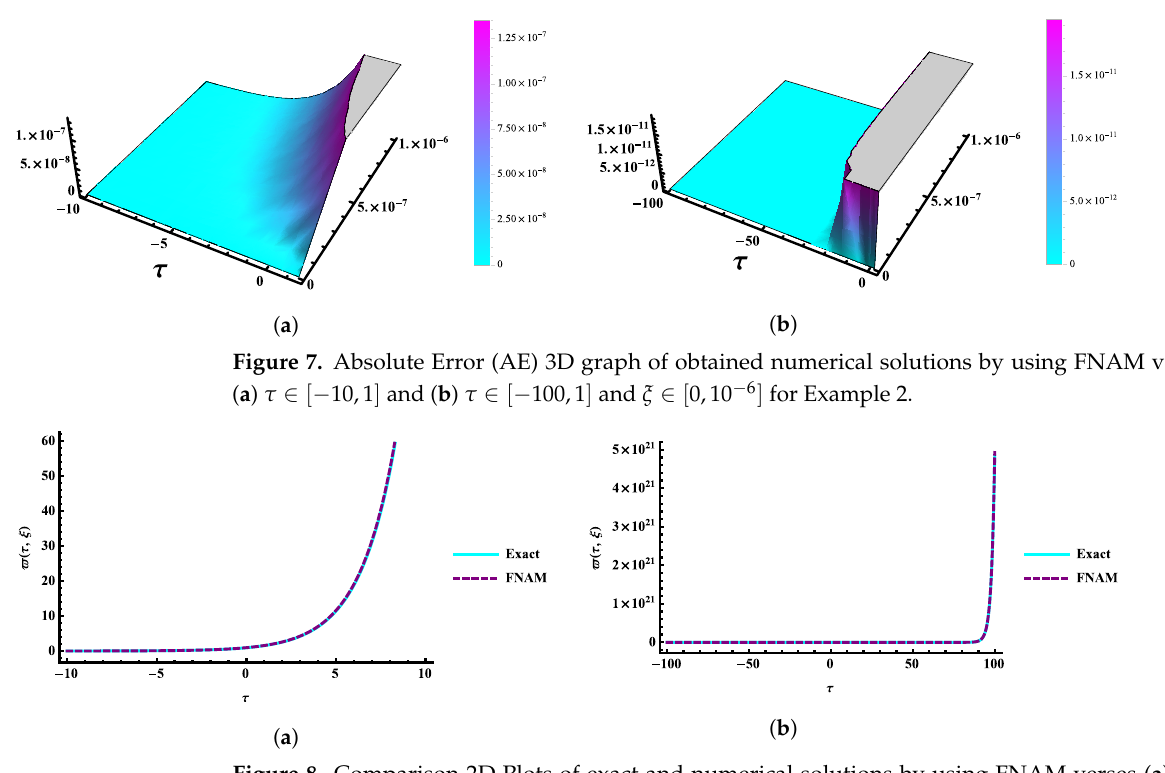
Figure 8. Comparison 2D Plots of exact and numerical solutions by using FNAM verses ( a ) τ ∈ [ − 10,10 ] and ( b ) τ ∈ [ − 100,100 ] at time ξ = 0.1 for Example